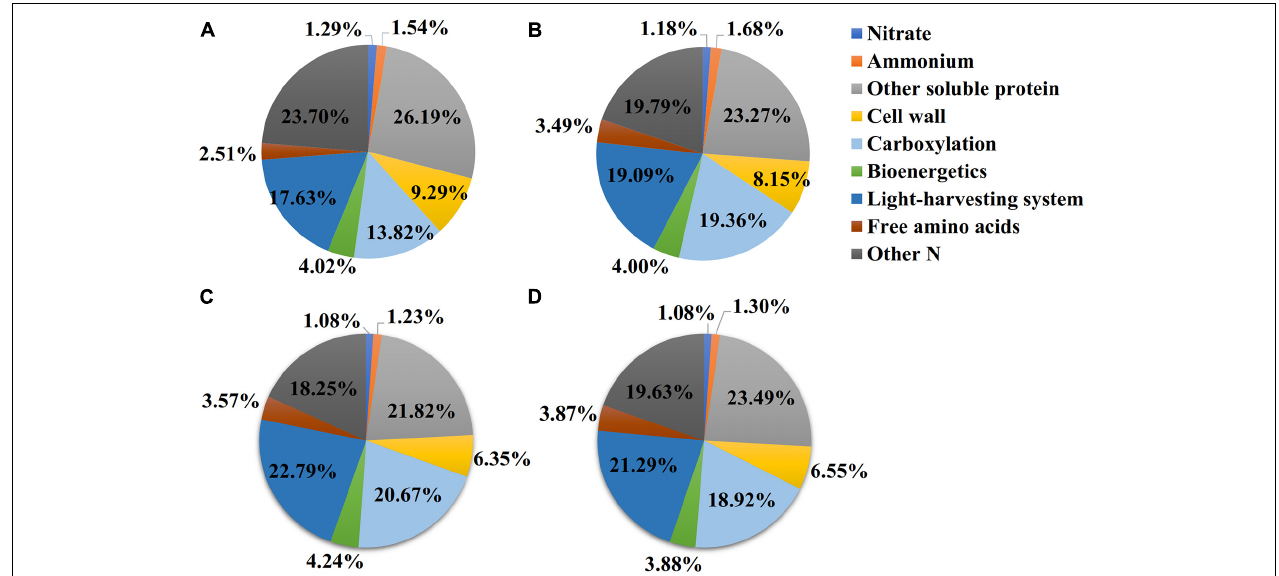
FIGURE 3 | Effect of N forms treatments on the N allocation in leaves. The data of percentages are the content of N in the corresponding components accounting for total leaf N content in L. chinensis . N0-treated (A) , NH 4 -treated (B) , NO 3 -treated (C) , and NH 4 NO 3 -treated (D) . The size of pie chart indicates N content ( p < 0.05) ( n =